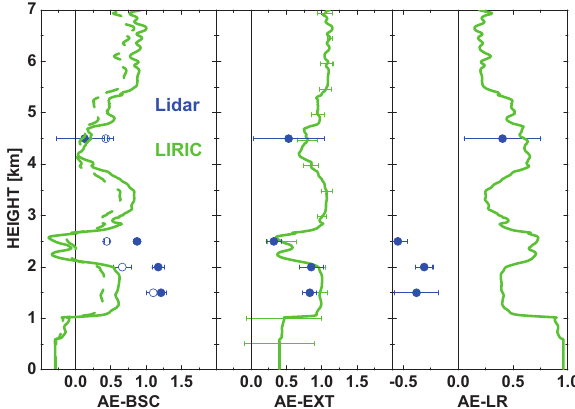
Fig. 13. Same as Figure 7, except for a volcanic dust observation on 19 April 2010. LIRIC profiles are derived from Figure 9 (green curves). Raman lidar observations (blue circles) were performed from 1330–1530 UTC. Raman lidar signals are smoothed with win- dow lengths of 660 m in the case of extinction coefficients and the lidar ratio.